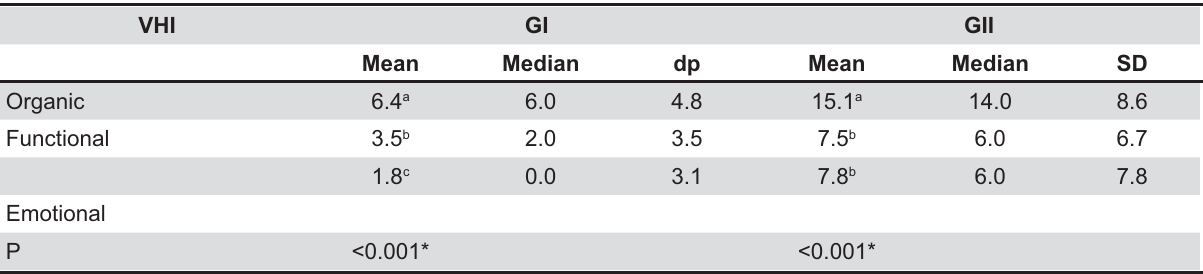
Table 2 - Comparison among the sub-areas of Voice Handicap Index(VHI) for GI (reported no vocal alteration) and GII (reported vocal